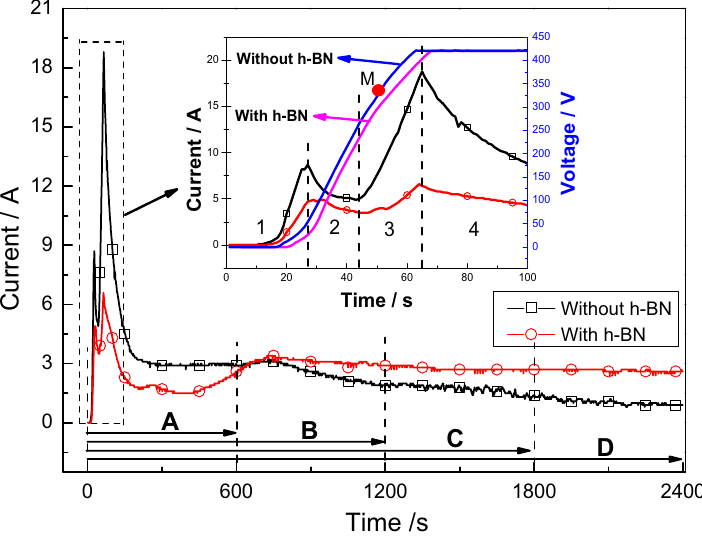
Figure 1. Electrical parameter-time response characteristics during the PEO